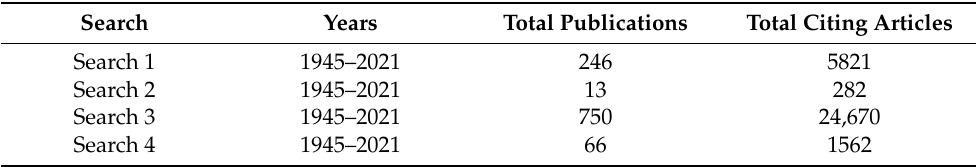
Table 1. Web of science search results prior to bibliometric